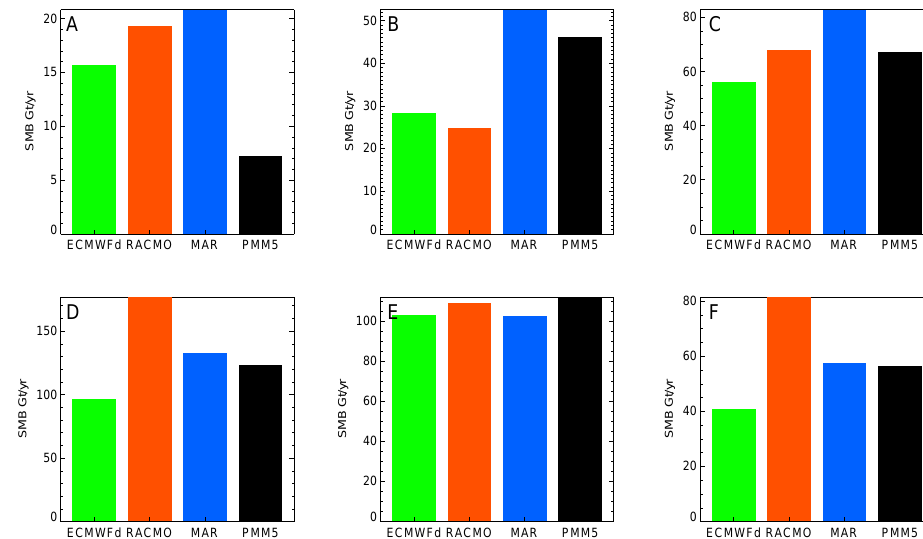
Fig. 7. Average annual SMB [Gtyr − 1 ] for six regions for the 1961–1990 period.